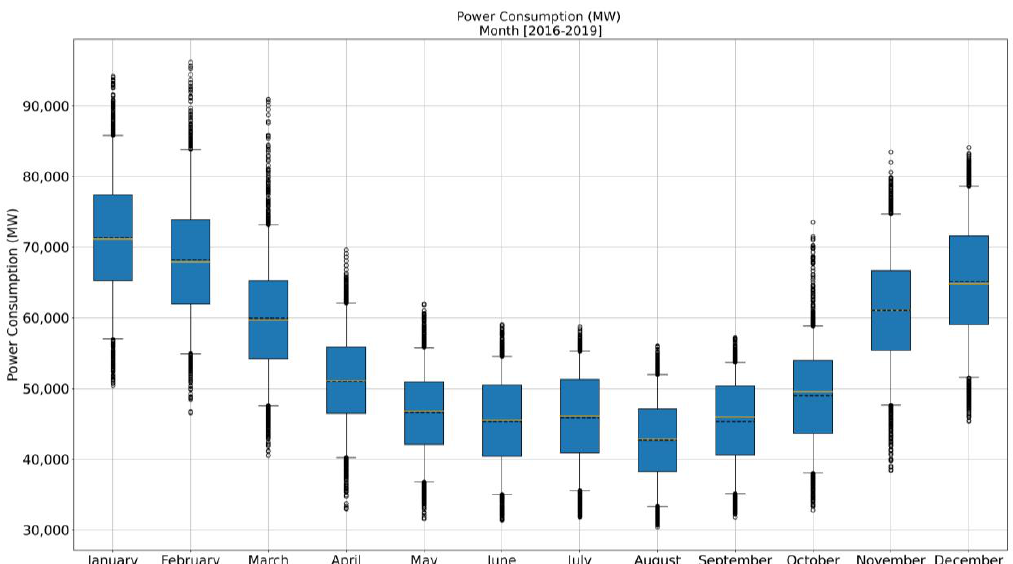
Figure 3. Monthly French power consumption for the period 2016 – 2019. The blue box indicates the Interquartile Range (IQR), while the lines to the ends correspond with the 95th and 5th percentile, respectively. The coloured lines within the IQR represent the mean (dashed black) line and the median (orange) line.